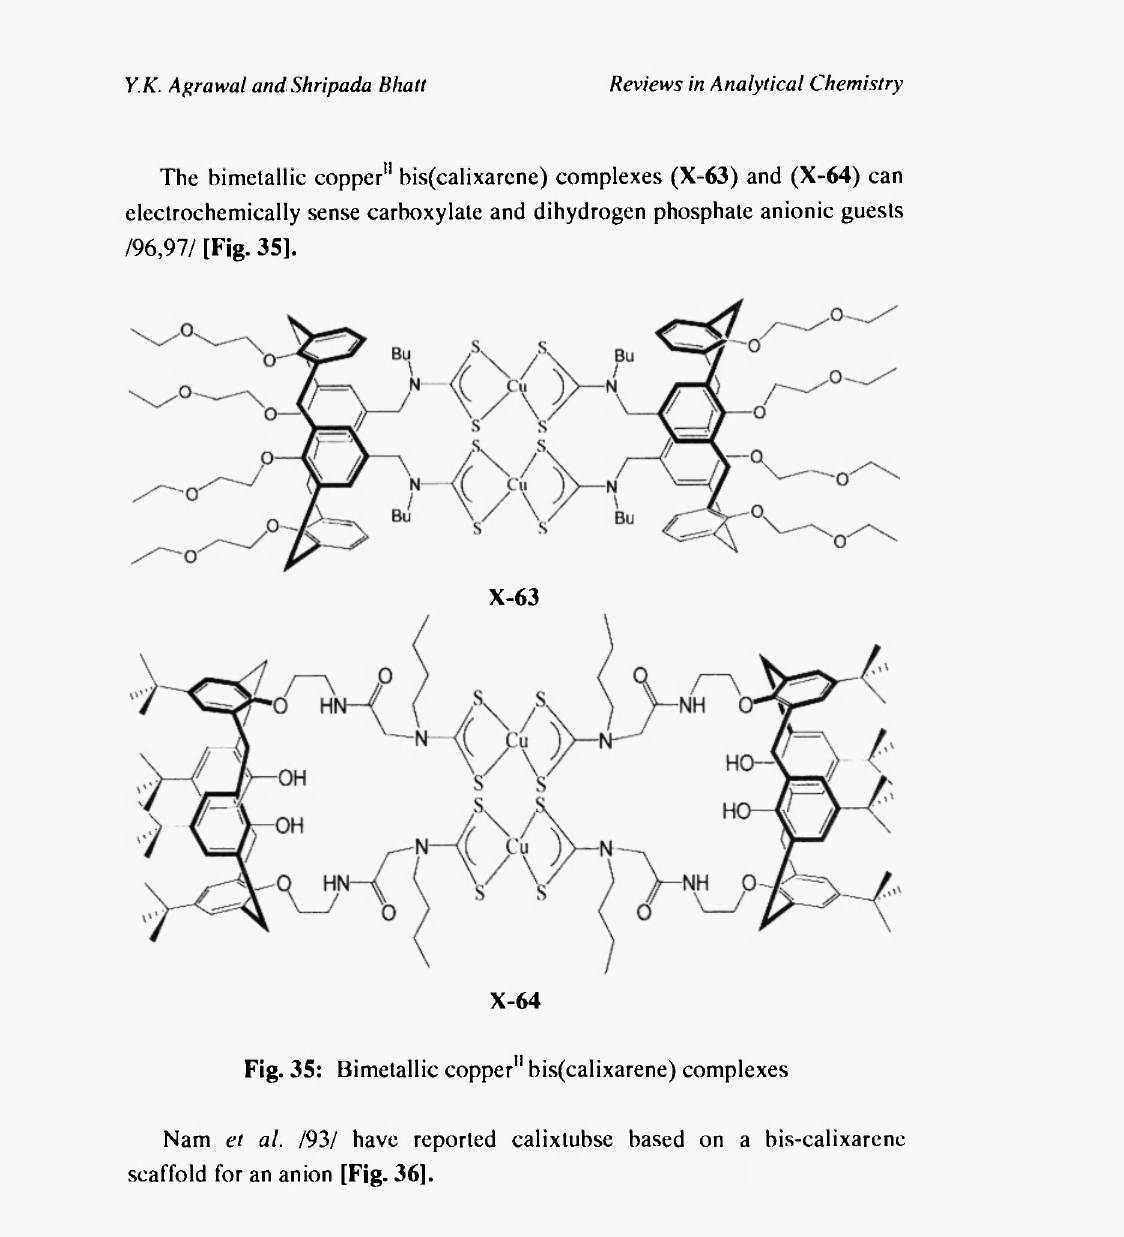
Fig. 35: Bimetallic copper" bis(calixarene)